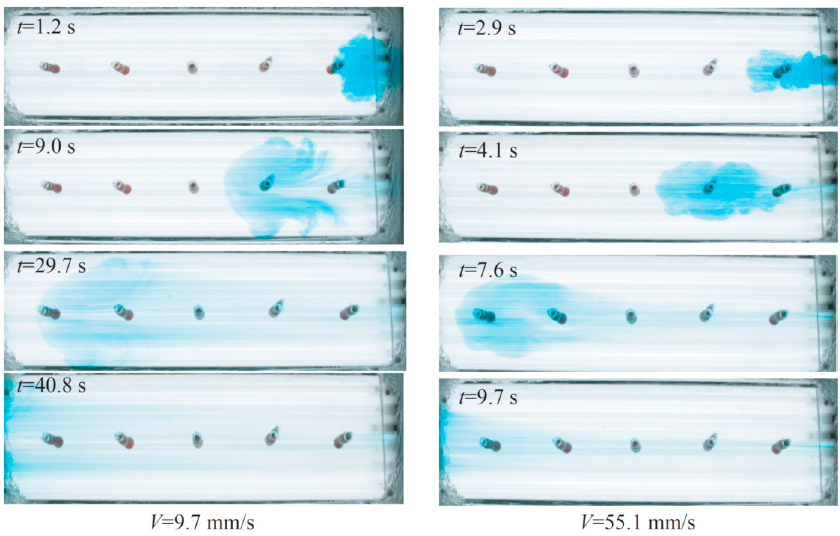
Figure 3. Solute plume of the tracer test in single fractures with smooth parallel plates. Water 2017 , 9 , 656